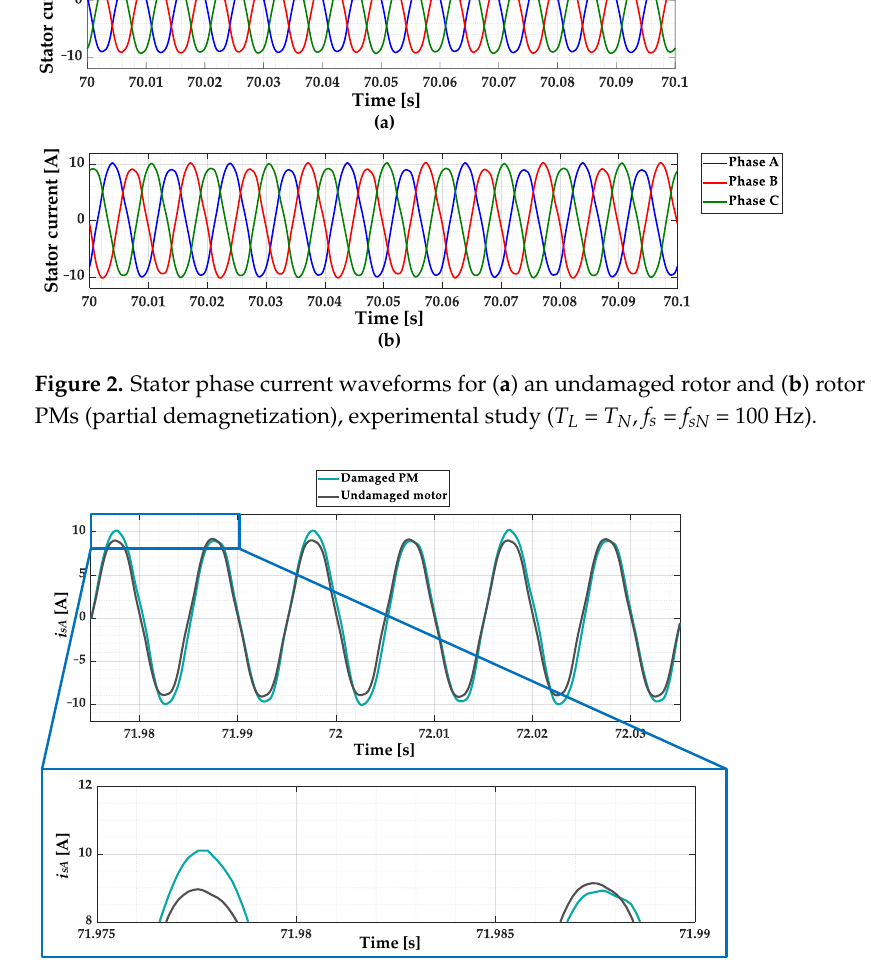
Figure 3. Comparison of the phase A stator current waveform for an undamaged rotor and rotor with damaged PMs (partial demagnetization), experimental study ( T L = T N , f s = f sN = 100 Hz).